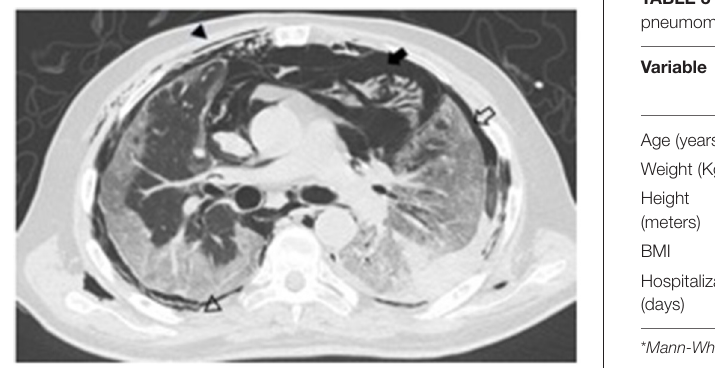
FIGURE 1 | A 68-year-old male axial non-enhanced chest CT image showing subcutaneous emphysema (arrow heads), pneumomediastinum (black arrow), and pneumothorax (empty arrow).